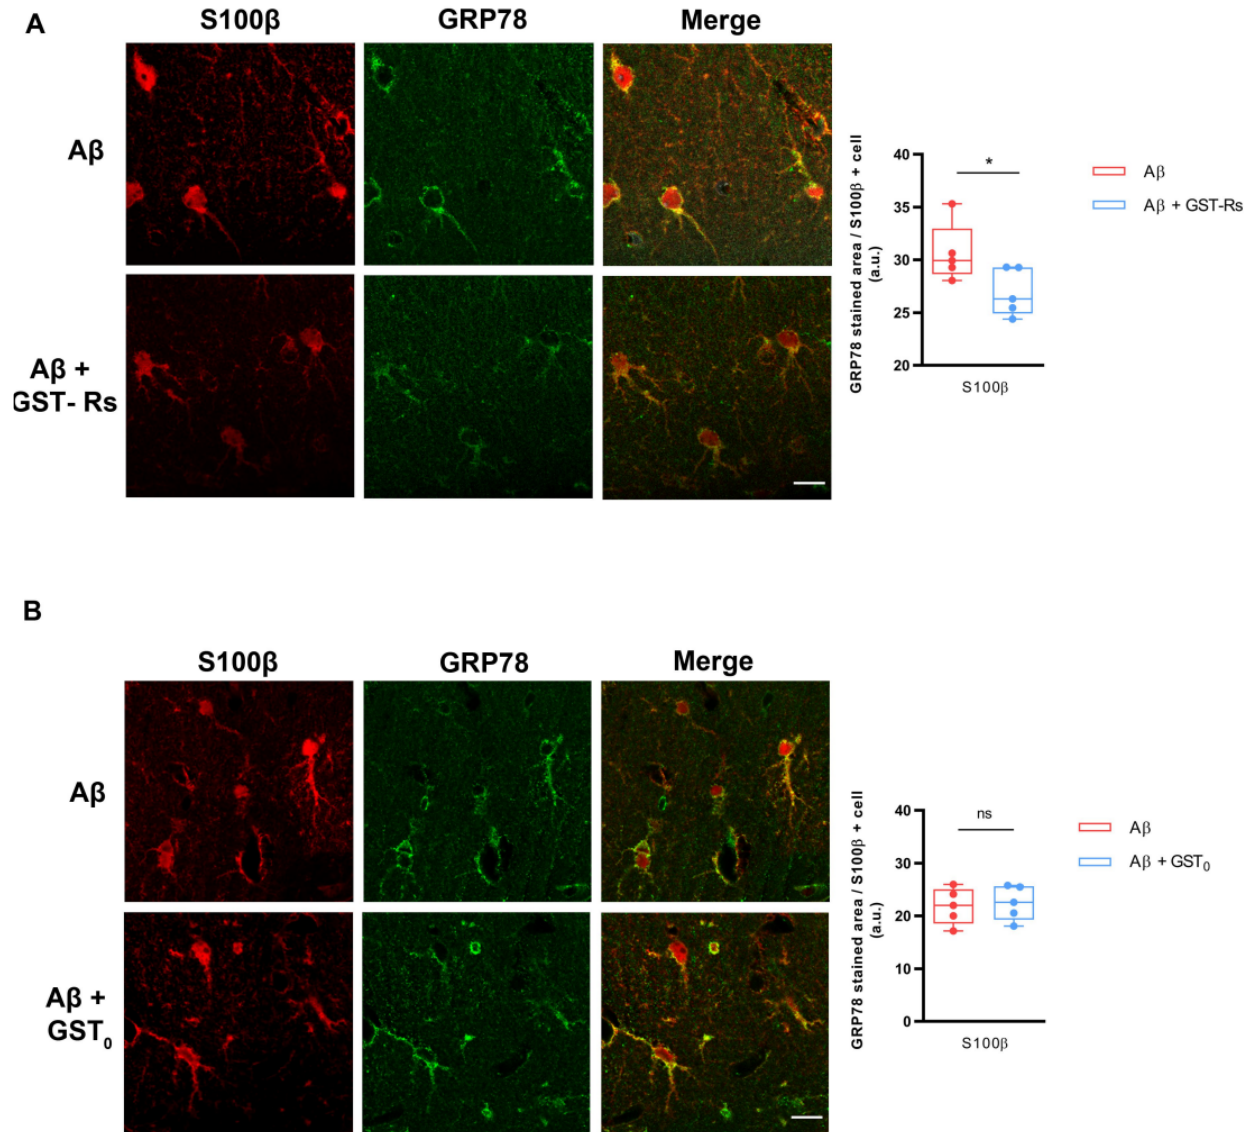
Figure 5. GST-R s polypeptide reduces GRP78 expression in S100 β -positive astrocytes of A β -injected mouse brains. Photomicrographs of double immunofluorescence staining for S100 β (red) and GRP78 (green) on DG of animals injected with different: A β and A β + GST-R s ( A ) or A β and A β + GST 0 ( B ). Quantitative analysis of fluorescence intensity was performed for GRP78 levels in S100 β -positive astrocytes in dentate gyrus after A β and A β + GST-Rs ( A ) or A β and A β + GST 0 ( B ). Scale bar in zoom area: 20 µ m. Data are presented as the mean ± SEM. Fifteen slices from five animals were analyzed per condition. ns: non-significant; * p < 0.05 compared with A β -injected mouse; unpaired Student’s